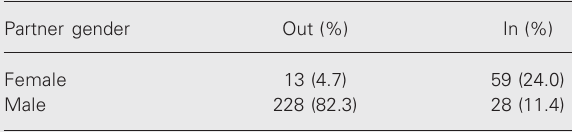
Table 2. Frequency of female prisoners who maintain sexual inter- course out of and in the Butantã Women’s Penitentiary, according to gender of the partners.